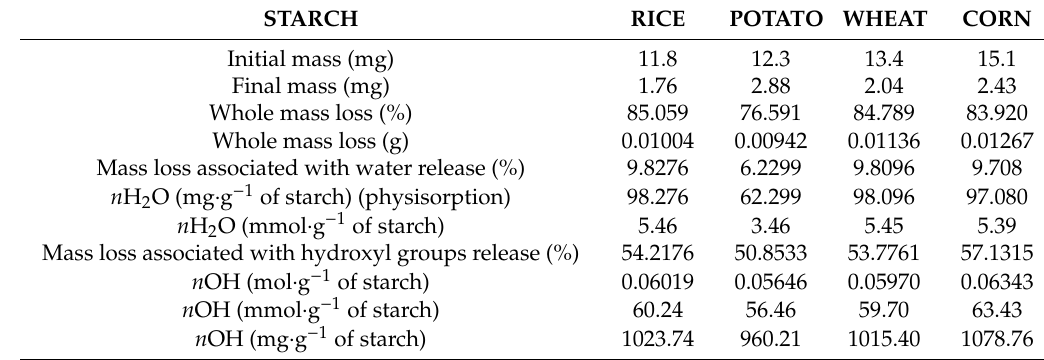
Table 4. Hydroxyl groups and physisorbed water determination on the surface of starches